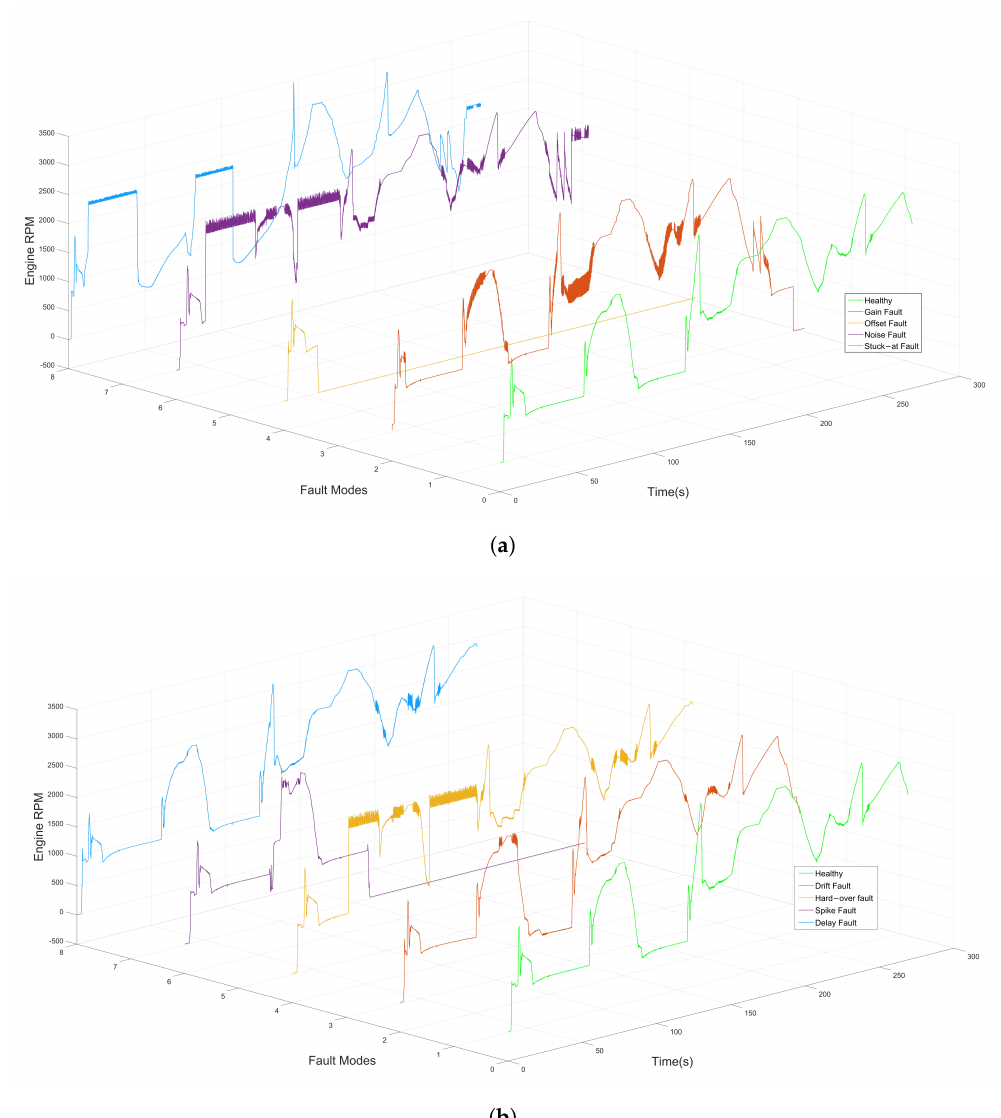
Figure 9. System behavior under fault conditions: ( a ) Gain, Offset, Noise, Stuck-at fault and Healthy signal. ( b ) Drift, Hard-over, Spike, Delay fault and Healthy